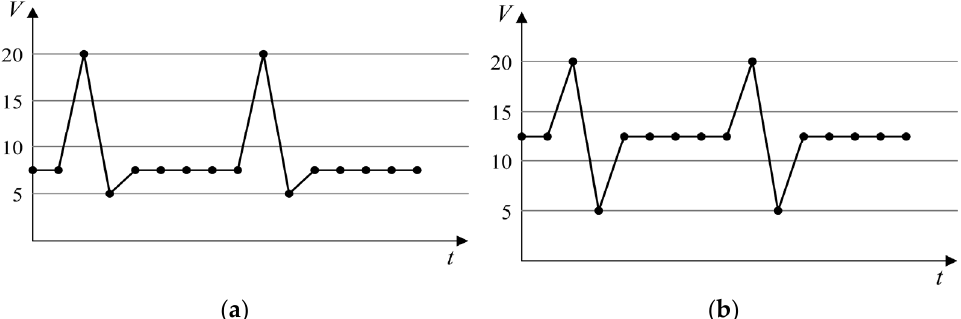
Figure 10. Two sketched voltage profiles for which the R p ,3 value is the same, but different steady state values and evidently different R p ,1 ripple value: ( a ) symmetric and ( b ) symmetric ripple. Whenever ripple is considered as caused by few rectifiers’ harmonics, the rms dis- tortion D and peak ripple factor R p can be made equivalent: R p = √ 2 D . In general, an in-